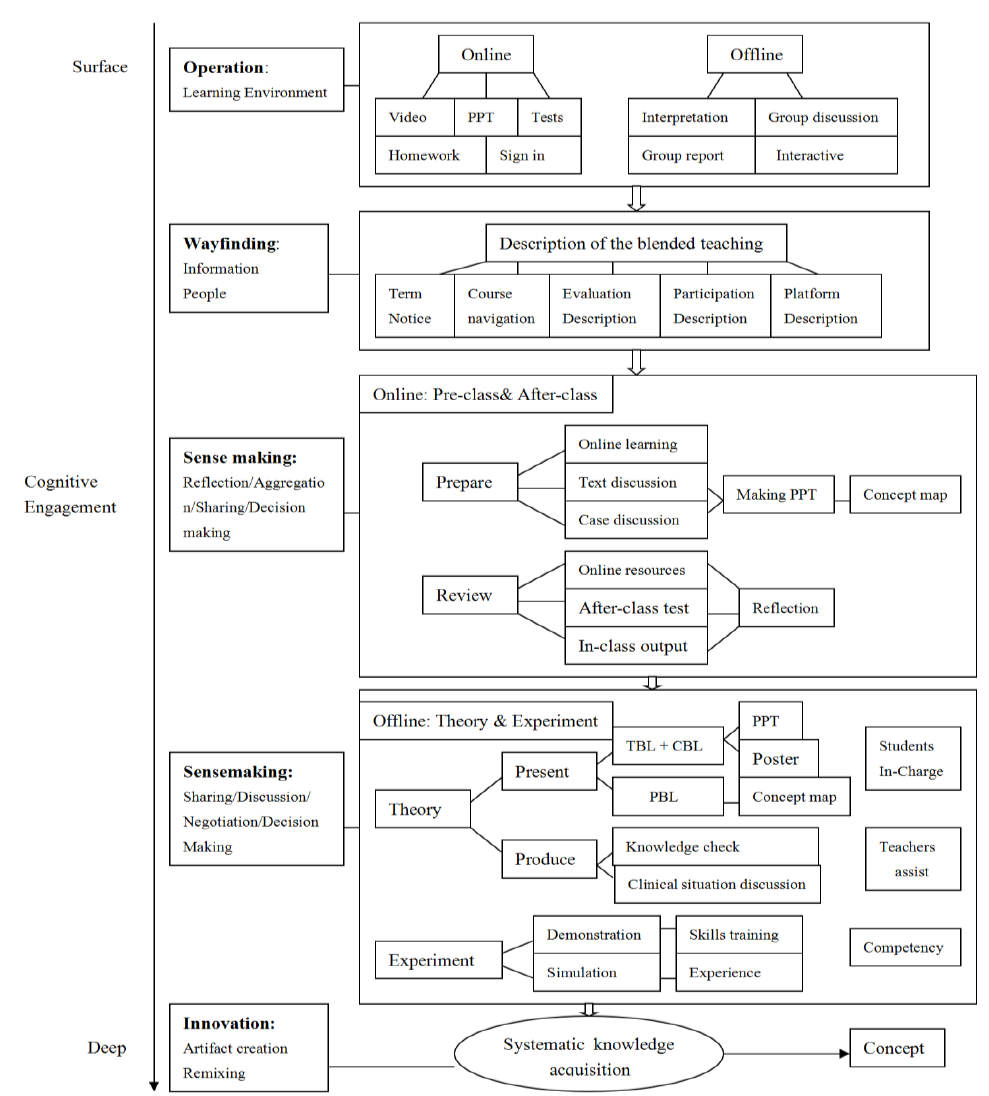
Figure 2. Framework for interaction and cognitive engagement in connectivist learning. Note: PPT- Power Point; TBL-Team-based learning; CBL-Case-based learning; PBL-Problem-based learning.